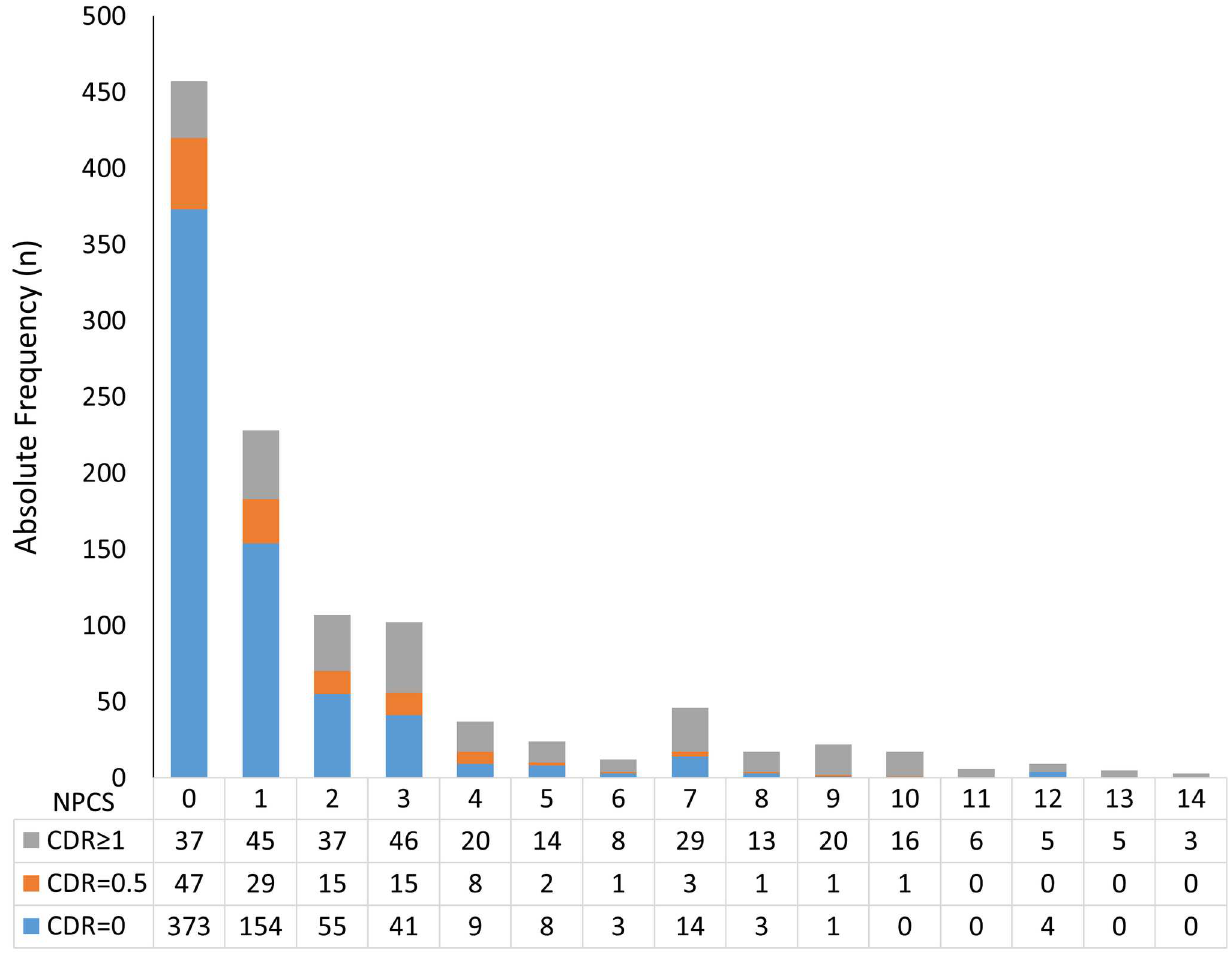
Fig 2. Number of participants in each stratum of the Neuropathological Comorbidity Score (NPCS) according to dementia status defined by the CDR scale (CDR = 0: No dementia; CDR = 0.5: Questionable dementia; CDR (cid:21) 1: Dementia).